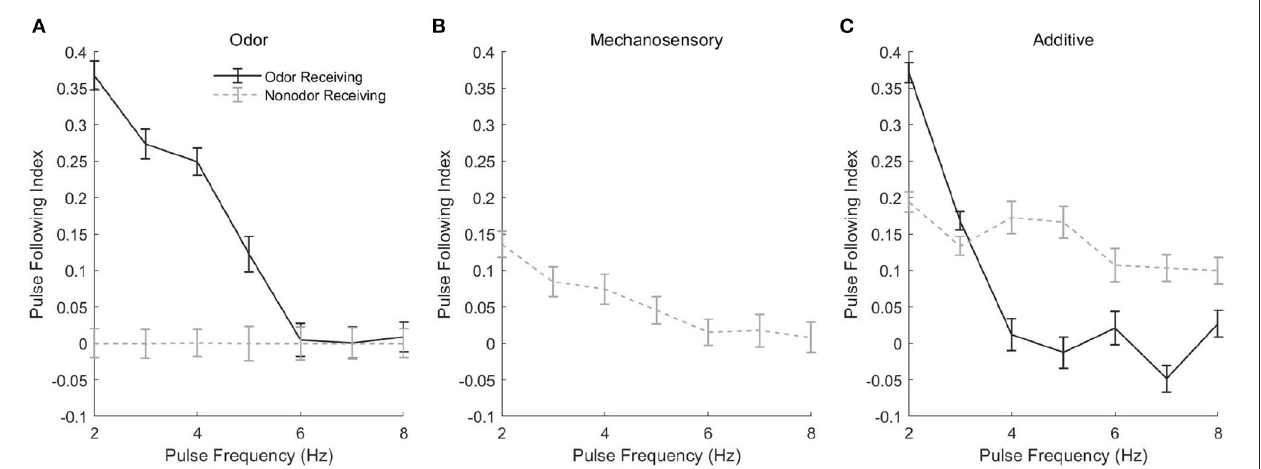
FIGURE 6 | Pulse Following Index as a function of pulse frequency for a single odor-receiving and a single non odor-receiving PN from the network, in the odor only (A) , mechanosensory only (B) , and additive sensory integration (C) stimulus scenarios. The pulse following index is a measure of the ability of the PN response to track the temporal dynamics of pulsatile stimulus delivery, with values above zero signifying sensitivity to pulsatile dynamics and a value of zero implying a lack of discernment of pulse structure (see section 4 for details). Data are averaged over 50